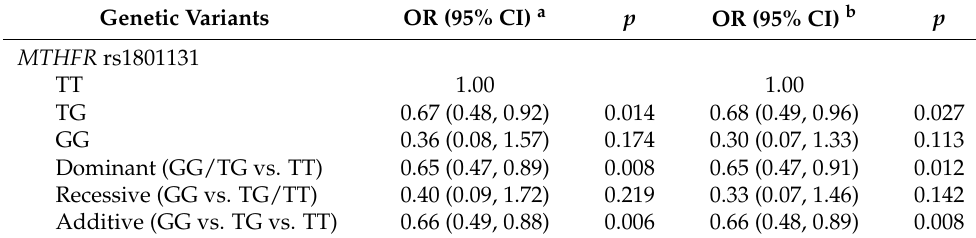
Table 3. Odds ratios of MTHFR rs1801131 genotype for GDM ( n =